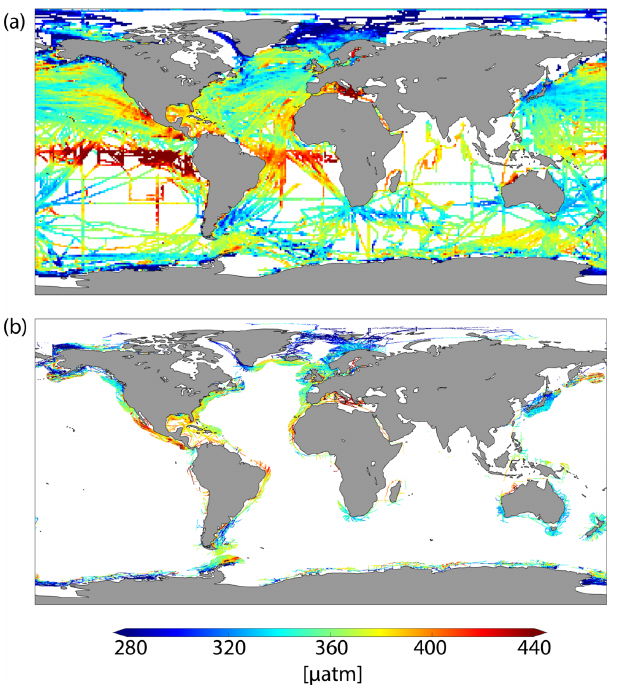
Figure 2. Climatological mean of the (a) 1 ◦ × 1 ◦ open-ocean p CO 2 product by Landschützer et al. (2016) and the (b) 0 . 25 ◦ × 0 . 25 ◦ coastal-ocean p CO 2 product by Laruelle et al. (2017) for the 1998– 2015